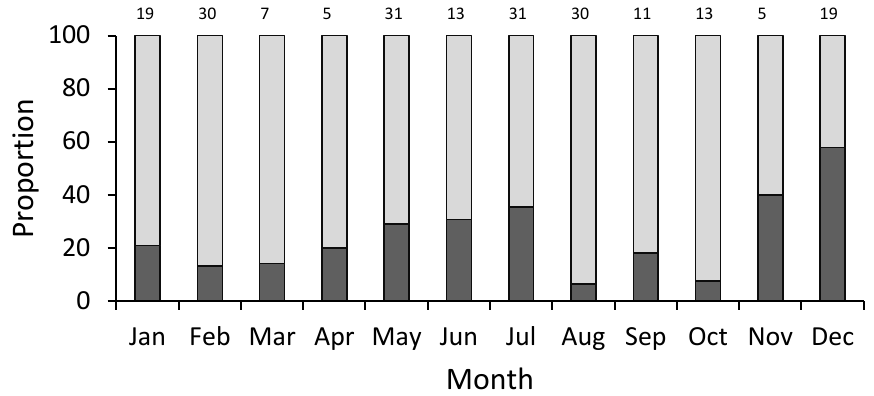
Figure 3. Proportion at length of immature (dark gray bars) and mature (light gray bars) females of Narcine entemedor throughout the study period ( n = 214). The sample size is denoted above each bar.